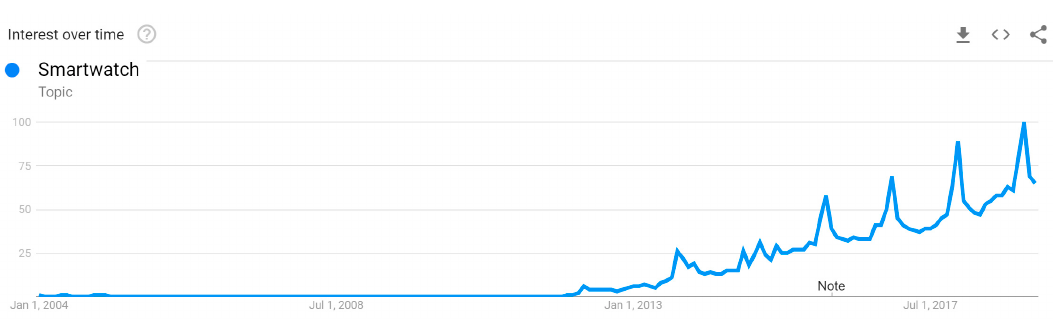
Figure 6. Google Trends for smart watches (January 2004–February 2019). (Data Source: Google Trends, 20 February 2019).